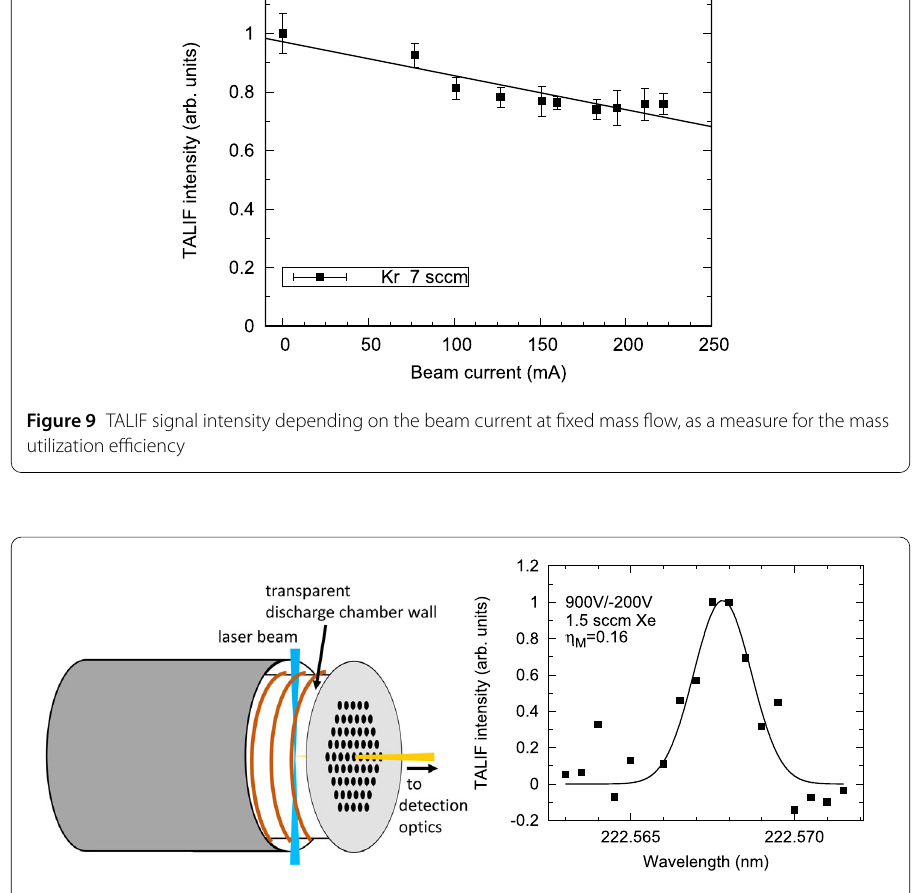
measured absorption profiles. For non-ground state LIF, the situation is different,